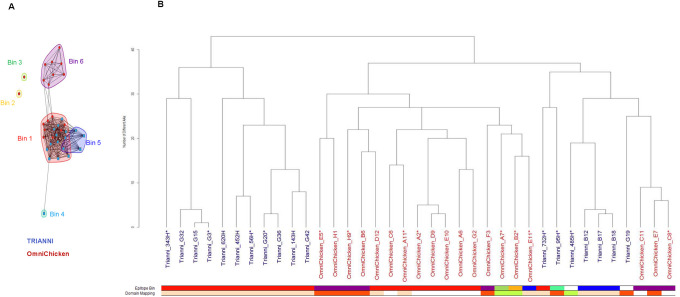
OmniChicken- and TRIANNI-derived mAbs target similar as well as distinct epitopes on LAMP1.(A) Epitope binning shows 6 epitope bins, two of which contain both OmniChicken- and TRIANNI-derived mAbs. Round-shaped spots indicate antibodies for which competition information was available regardless of the presentation (immobilized and in solution). Square-shaped spots indicate antibodies for which competition information was available in only one direction (mostly in solution). B) Paratope sequence tree of the 37 antibodies constructed using the Levenshtein distance based on the amino-acid differences within the six complementarity-determining regions (CDRs) defined according to international ImMunoGeneTics information system® (IMGT). Bars at the bottom indicate the epitope bin to which each antibody is assigned with colors corresponding to those in panel A, and the LAMP1 domain to which each antibody binds with colors corresponding to those in Fig 3. Two antibodies, TRIANNI_485H and TRIANNI_G19, bound poorly in this experiment and were not assigned to an epitope bin. Asterisks (*) indicate mAbs further characterized in the developability study.